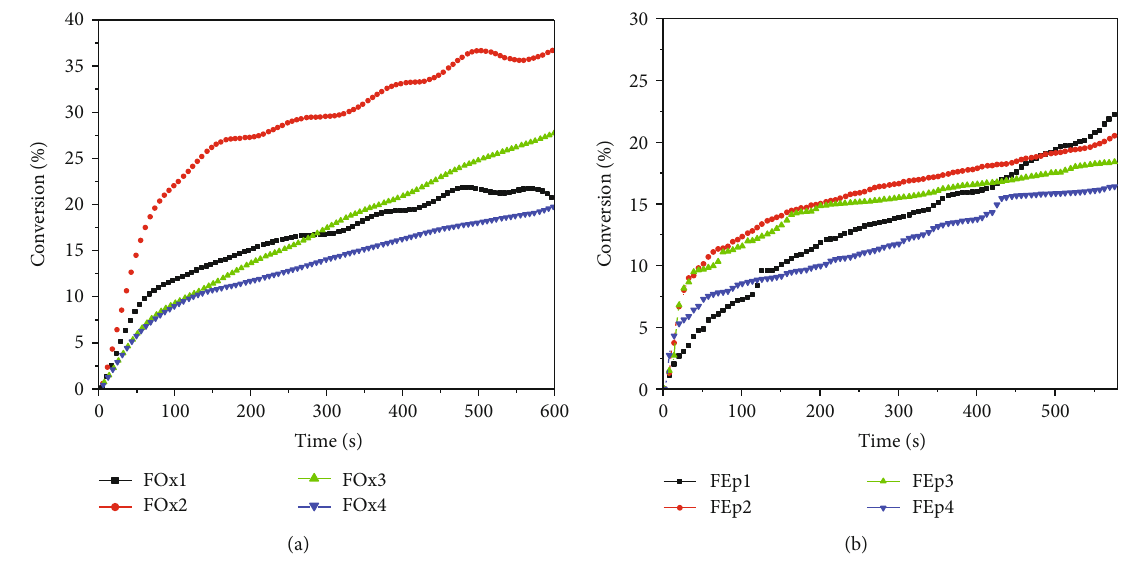
Figure 4: Conversion curves of 60 wt% prepolymer C1 formulations with DDE and M1 (a) and M2 (b) monomer system, M1: TMPO/ DOX = 60/40 ( w / w ); M2: ECH/EEC = 60/40 ( w / w ). Table 5: Antistain performance of cured fi lms for di ff erent